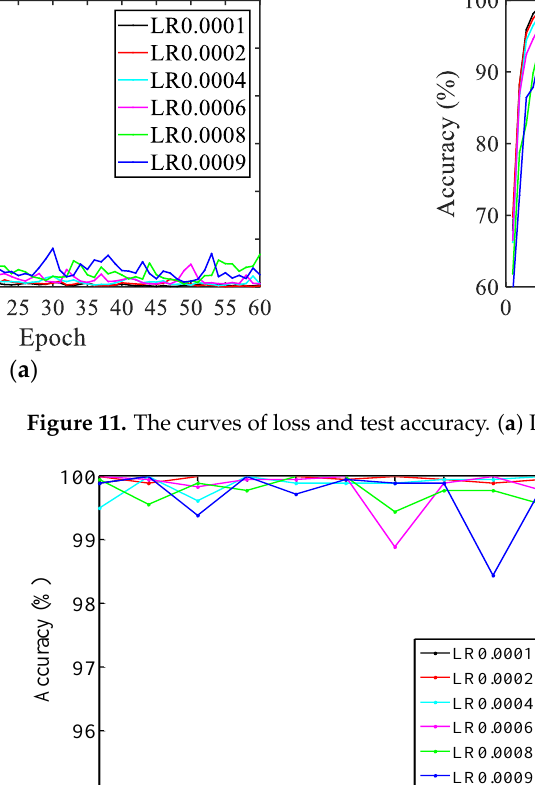
Figure 11. The curves of loss and test accuracy. ( a ) Loss , ( b ) accuracy .